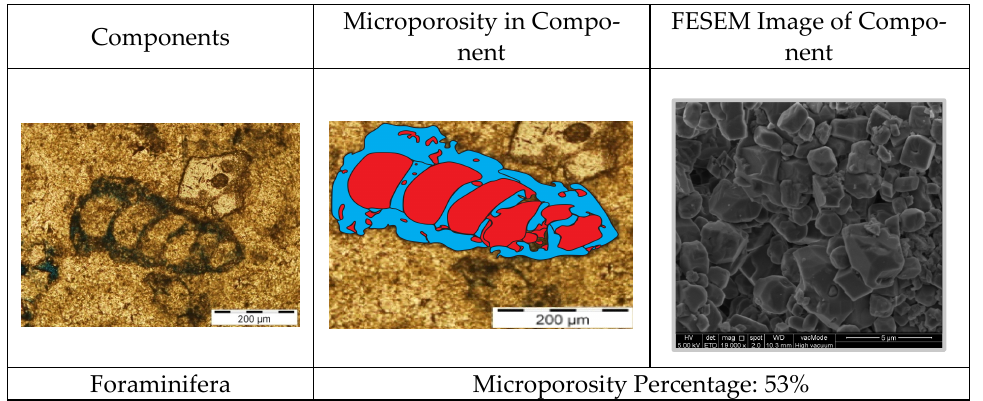
Figure 10. A systematic evaluation of microporosity in carbonate allochems (e.g., Foraminifera), Central Luconia, offshore, Sarawak, Malaysia.